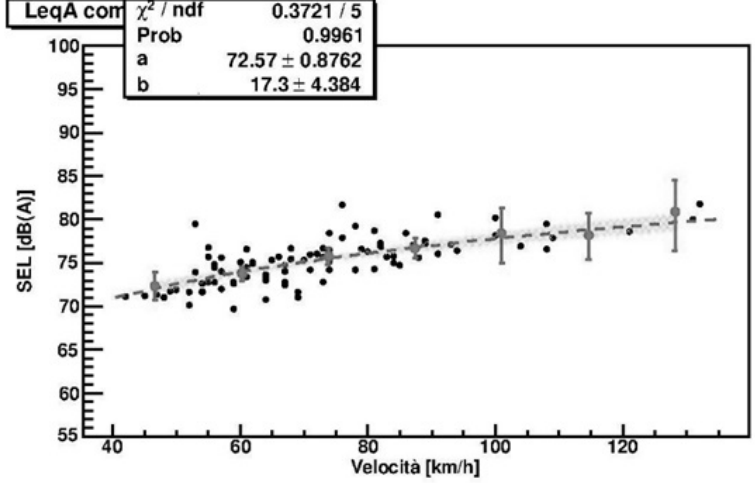
Figure 1. Example of fit performed with binning